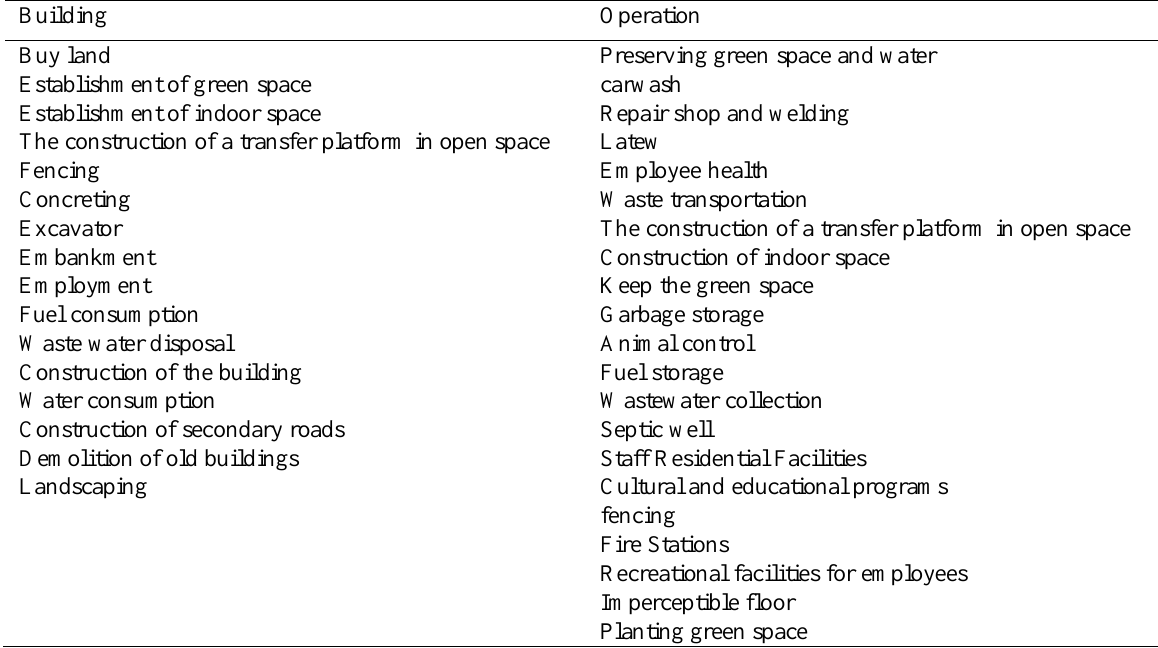
Table 3. Building and operation activities in Iranian Leopold matrix Building